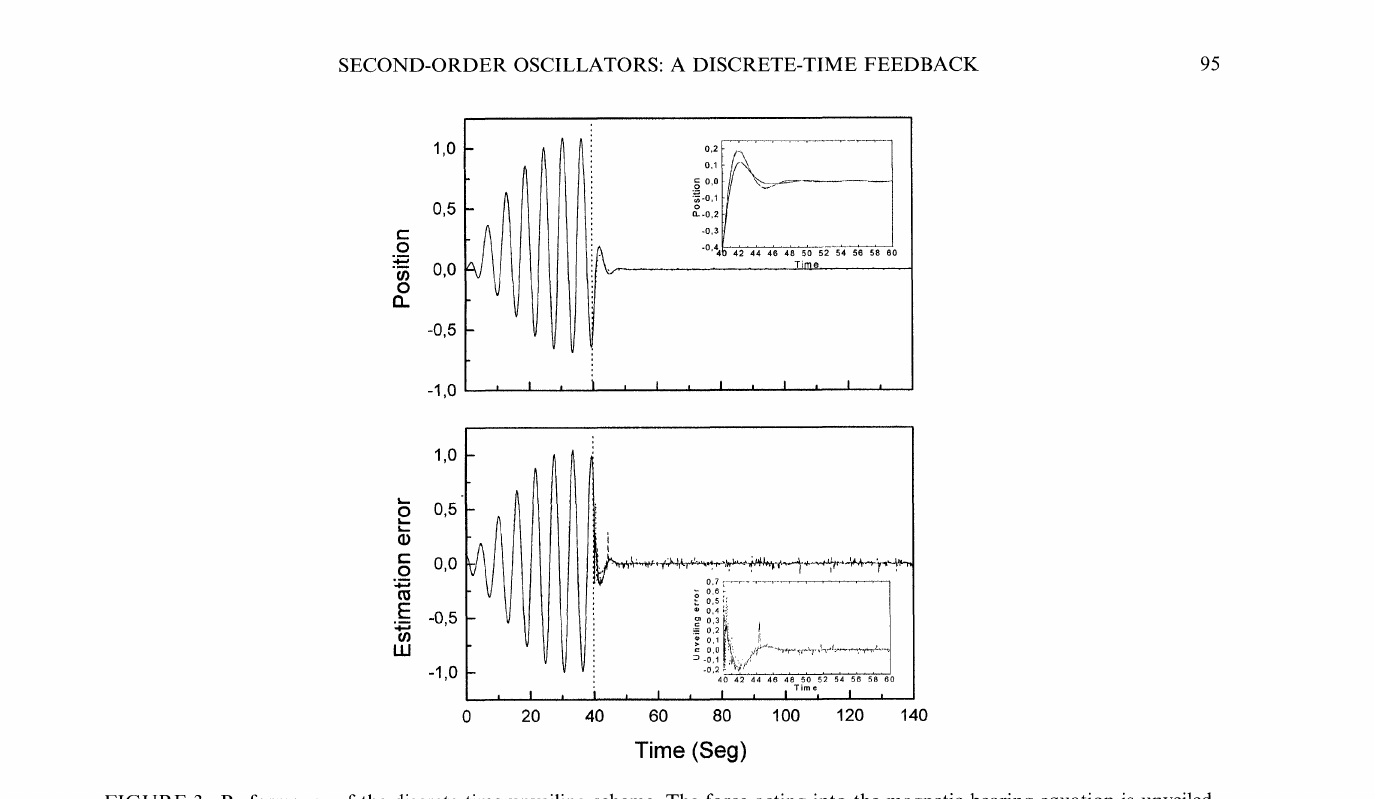
FIGURE 3 Performance of the discrete-time unveiling scheme. The force acting into the magnetic-bearing equation is